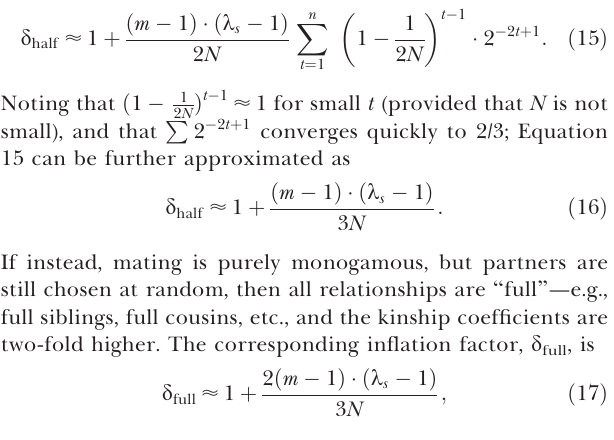
Table 1. Values of the Inflation Factor as a Function of Model Parameters, and a Comparison of the Simulated ( ^ d mean ) and Analytical ( d A ) Predictions, for Populations of Constant Size k s Sample Size